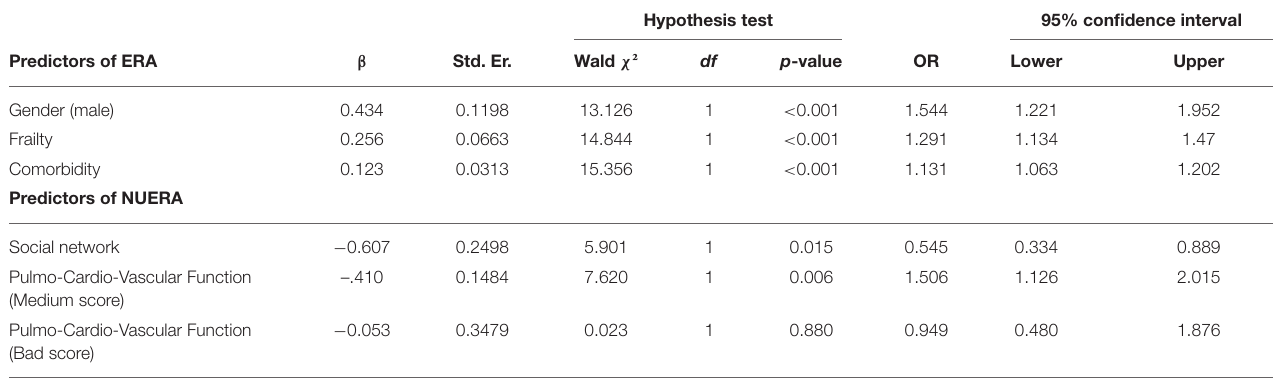
TABLE 3 | Ordinal logistic (GENLIN) models were predicting determinants of ERA and NUERA. Hypothesis test 95% confidence